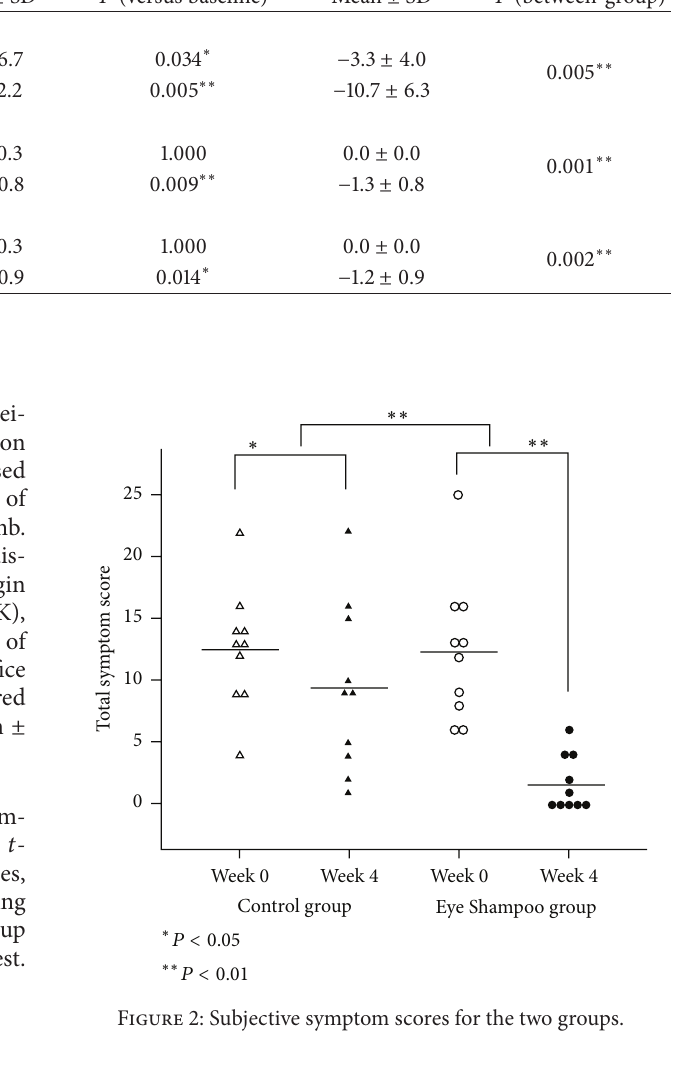
Table 3: Comparison of symptoms, orifice obstruction, and decreased meibum secretion between the groups. Group/task